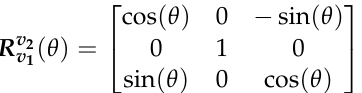
( φ ) defines a rotation around the x -axis of the coordinate system V Finally, matrix R b v 2 for angle φ . Again, the rotation creates a new, body coordinate system B whose x -axis is aligned with the x -axis of the V 2 coordinate system, while the y and z -axis of the coordinate system B are rotated for angle φ with respect to the coordinate system V 2